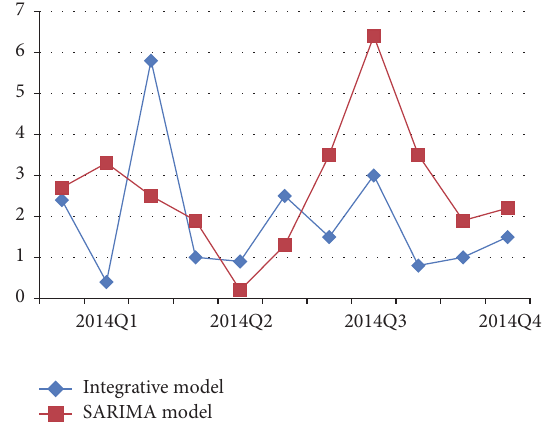
Figure7:PredictionandoriginaldataofthelinegraphfromJanuary to November in